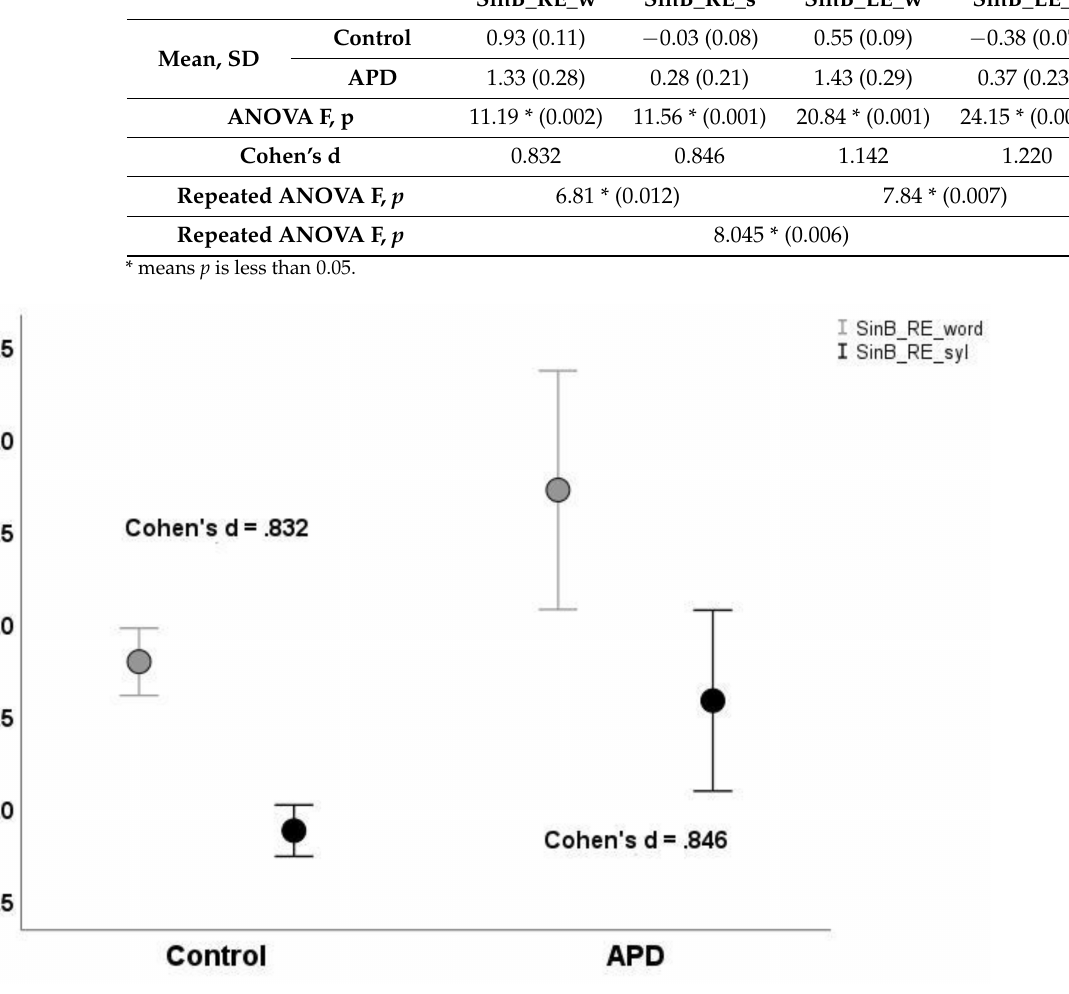
Figure 1. (SinB RE) Means and 95% error bars for SinB word (bright circles rectangles) and syllable- based scores (dark circles) for control and APD (Auditory Processing Disorder) children, right ear. Cohen’s d values refer to the effect size between typically developing and APD (Auditory Processing Disorder) groups for word and syllable-based